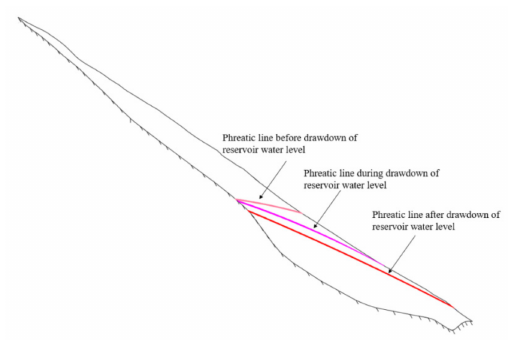
Figure 10. Schematic diagram of groundwater seepage in the accumulation layer of the